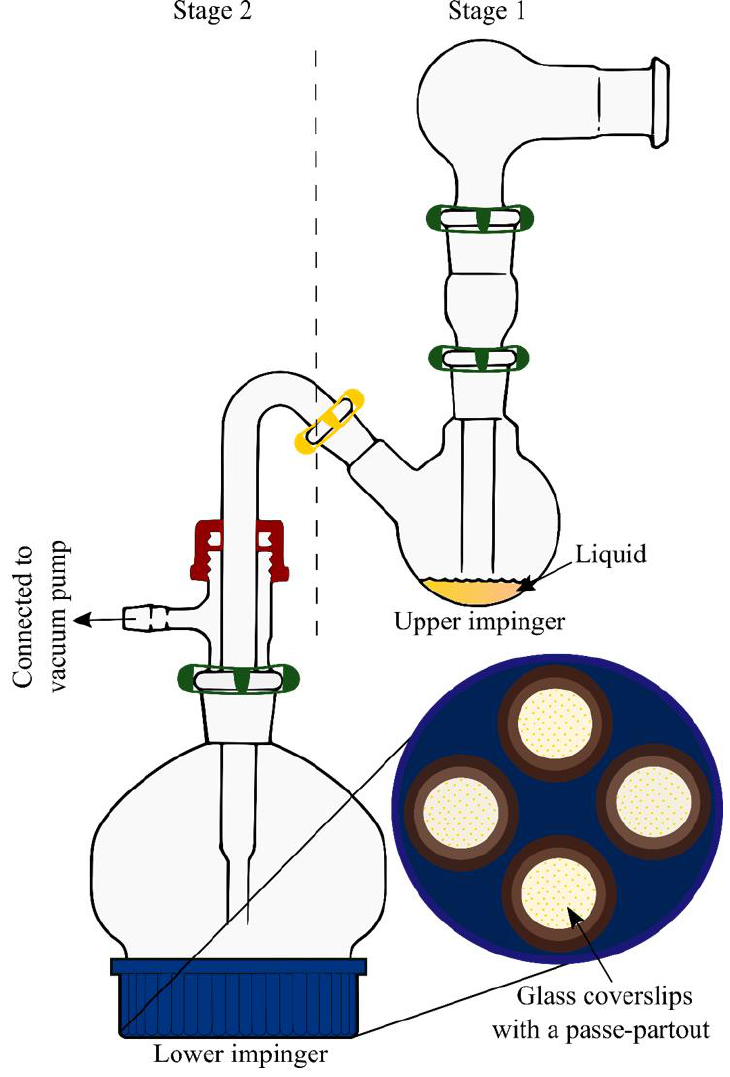
Figure 3. A modified Twin Stage Impinger (mTSI) to collect fine particle dose (FPD). Reproduced with permission from Eedara et al., 2019 [62], Springer